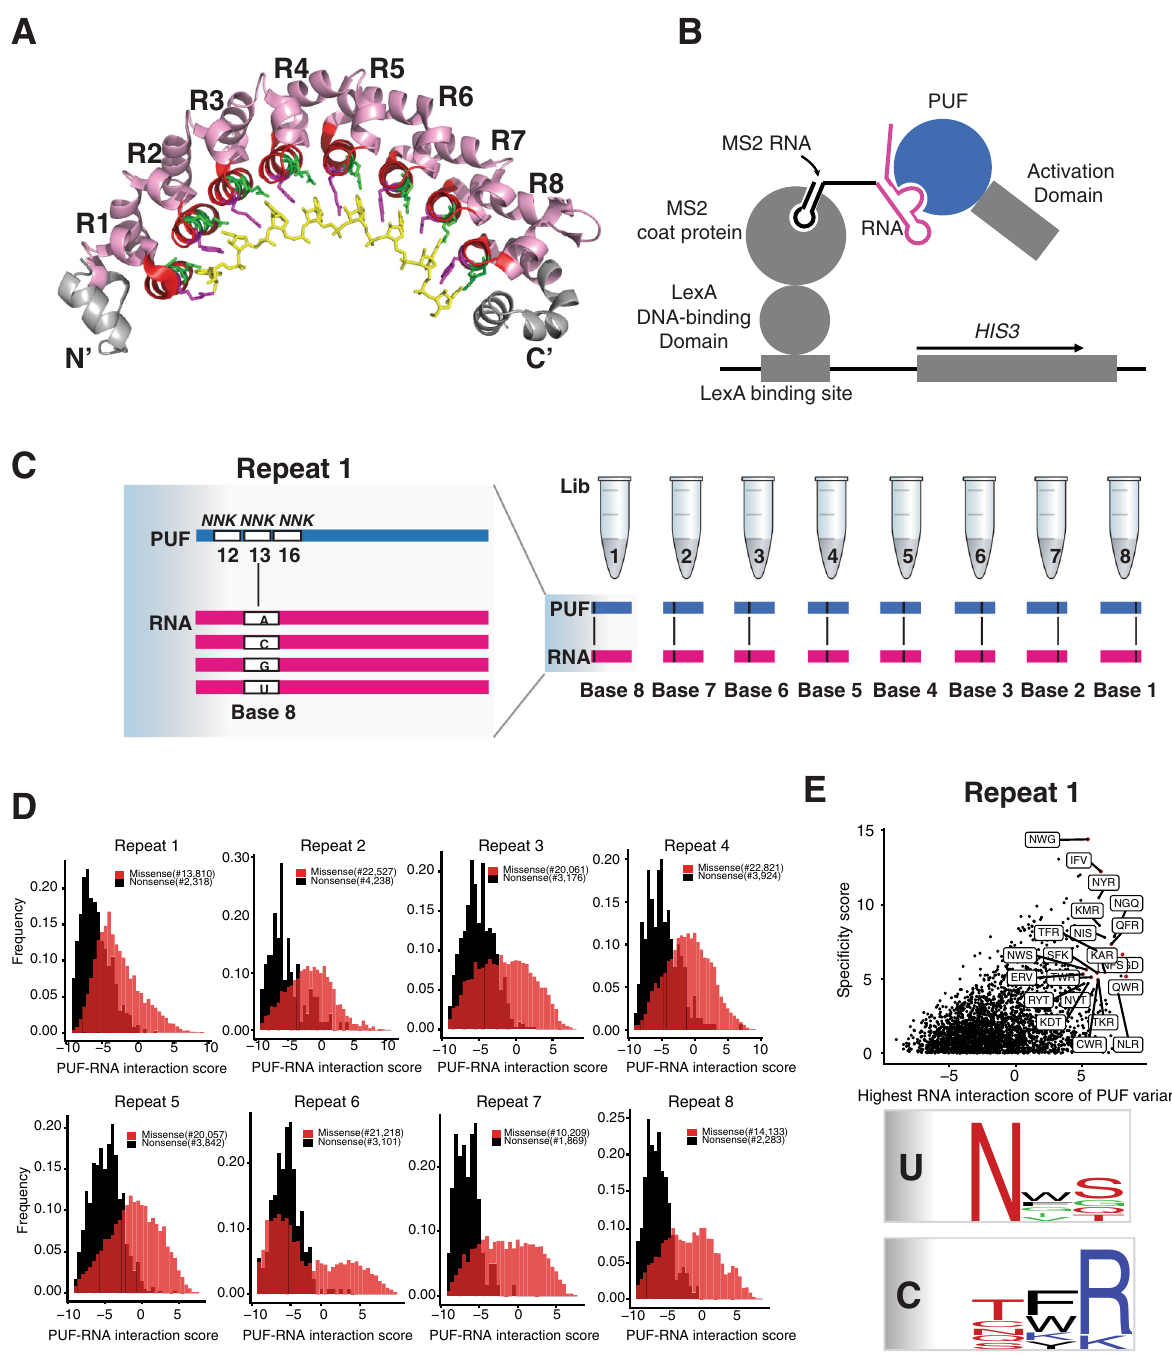
Fig. 1 A high throughput yeast three-hybrid assay to identify PUF variants. A Crystal structure of the human Pumilio-1 PUF domain in complex with NRE10 RNA (PDB ID 1M8Y) 26 . Helices that carry functional RNA-binding residues (TRM residues) are colored in green and purple. TRM residues 12 and 16 are in green and position 13 is in purple. The RNA bases of the NRE10 recognition sequence are colored in yellow. B The yeast three-hybrid system was adapted for deep mutational scanning of the Pumilio-1 PUF domain TRM residues. Binding of the Pumilio-1 PUF domain to its cognate RNA sequence leads to the formation of a functional transcription factor that induces the expression of the reporter gene, HIS3 . As a result, yeast cells that carry functional PUF- RNA interactions proliferate in media lacking histidine, while yeast cells that carry non-functional PUF-RNA interactions will be eliminated. C Work fl ow to analyze all possible TRM combinations (~8000) against the four possible RNA bases for each PUF repeat through deep mutational scanning. The left panel is shown as randomization of Repeat 1 and Base 8. D The frequency distribution of nonsense and missense PUF variants for all repeat locations. The X -axis is a measure of PUF-RNA interaction score. Black indicates nonsense variants and red indicates missense variants. E A plot showing the RNA interaction score and speci fi city score of each PUF variant in repeat 1. The X -axis indicates the highest RNA interaction score of each PUF variant. The Y -axis indicates the speci fi city score for each PUF variant. Each dot indicates one PUF variant and the red dot highlights those PUF variants with interaction score >5 and speci fi city score >4. The lower panel summarizes the base-speci fi c recognition pattern for uracil and cytosine through sequence